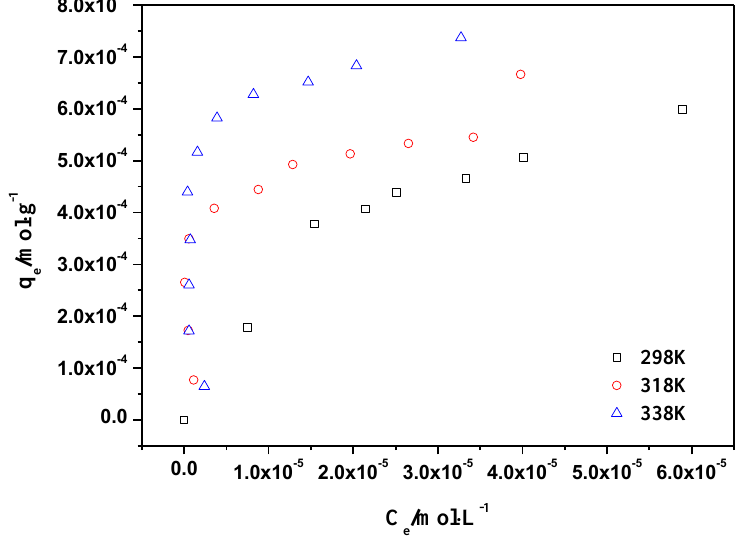
Figure 7. Adsorption isotherms of Th(IV) on oMWCNTs at three different